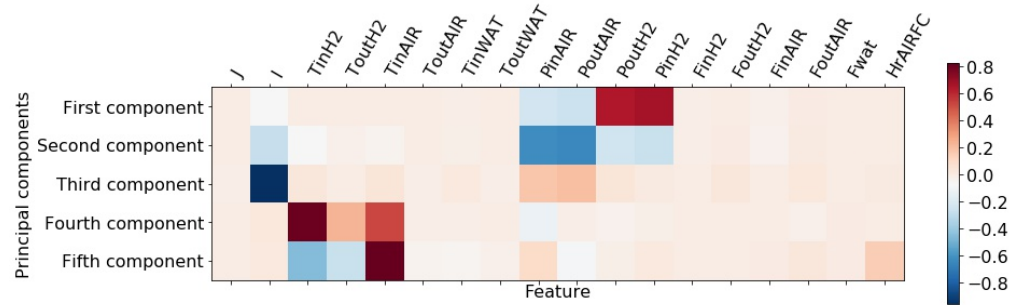
Figure 6. Fuel cell correlation matrix.